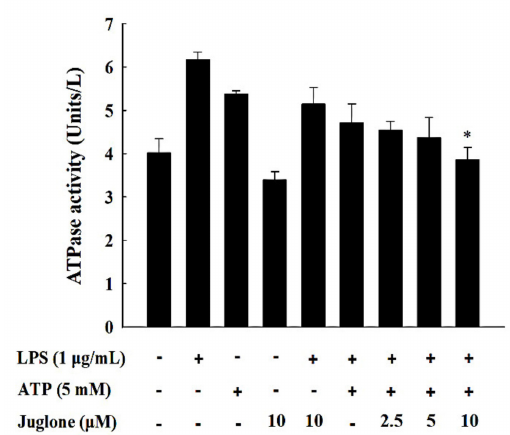
Figure 5. E ff ects of juglone on the ATPase activity of NLRP3 in LPS / ATP-treated J774.1 cells. J774.1 macrophages were treated with di ff erent concentrations of juglone for 2 h, followed by treatment with 1 µ g / mL LPS for 6 h and 5 mM ATP for an additional hour. Analysis of the ATPase activity of NLRP3 was performed using a reaction mixture containing 40 mM Tris, 80 mM NaCl, 8 mM MgAc2, 1 mM EDTA, and 4 mM ATP, pH 7.5. Data are presented as mean ± SD of three independent experiments. * p < 0.05 vs. LPS / ATP treated